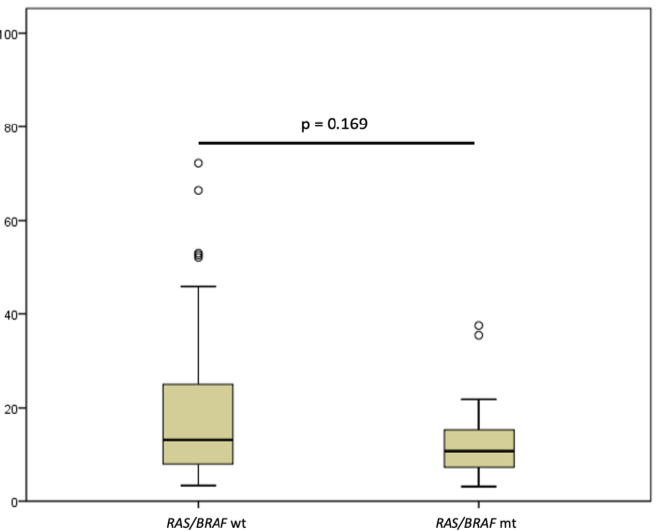
Figure 2. Association of median anti-epidermal growth factor (EGFR)-free interval and RAS / BRAF mutational status. Median anti-EGFR free interval was 10.6 months (CI 95% 8.95–13.4) in patients with RAS / BRAF mutant circulating tumor DNA (ctDNA), and 13.01 months (CI 95% 11.1–16.6) in patient with RAS / BRAF wild-type (WT) status ( p = 0.169).